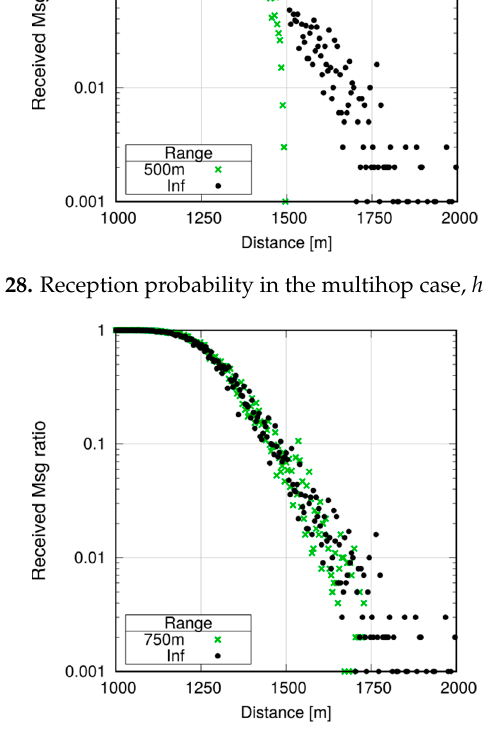
Figure 29. Reception probability in the multihop case, h = 750 m.